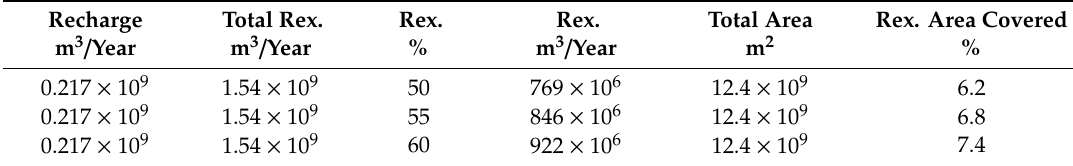
Table 5. External recharge